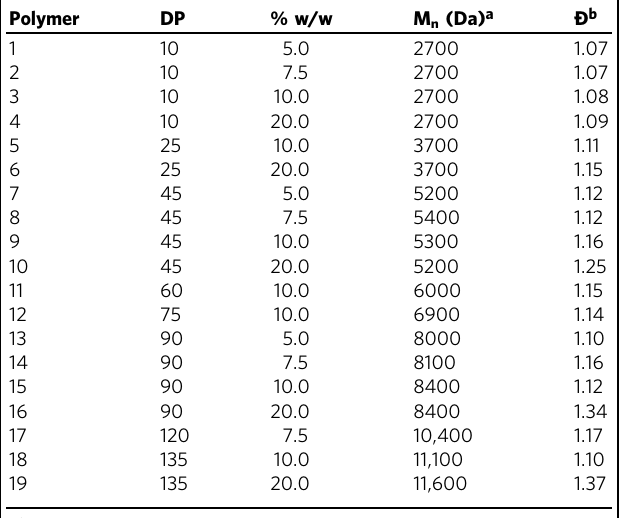
polymerization for 5 (PLLA 25 - b -PEG 45 10% solids w/w) and 7 (PLLA 45 - b -PEG 45 5% solids w/w). This indicates that in most instances the relaxation time is signi fi cantly longer than the the BCP. Here, relaxation time refers to the time taken for the